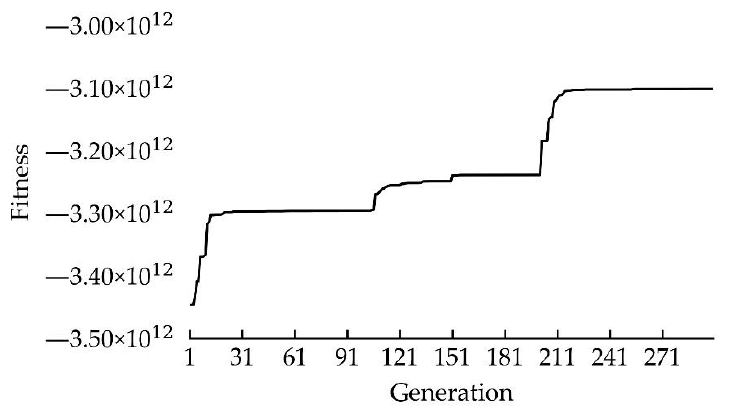
Figure 5. Evolution process using sampling stochastic dynamic programming rule as an initial solution.